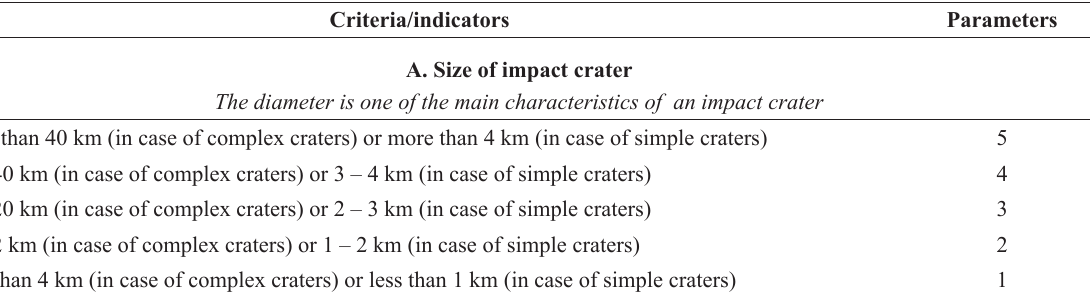
criteria, indicators, and parameters used for the quantitative assessment of the scientific value of impact structures. the indicators concerning criteria a and d are different taking into account the intrinsic characteristics of simple and complex